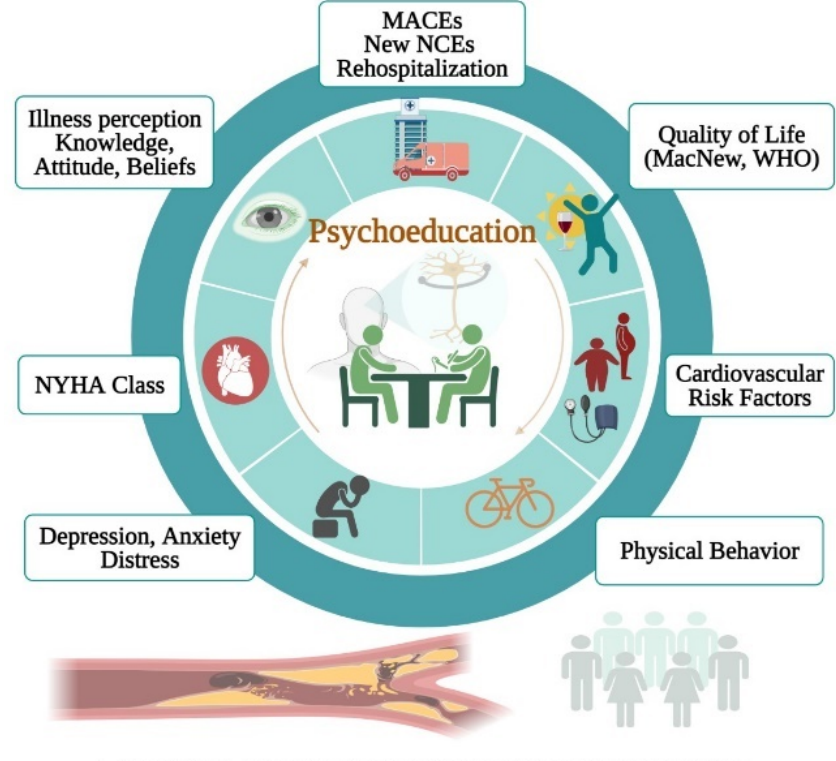
Figure 2. Benefits of psychoeducation rehabilitation focused on acute coronary